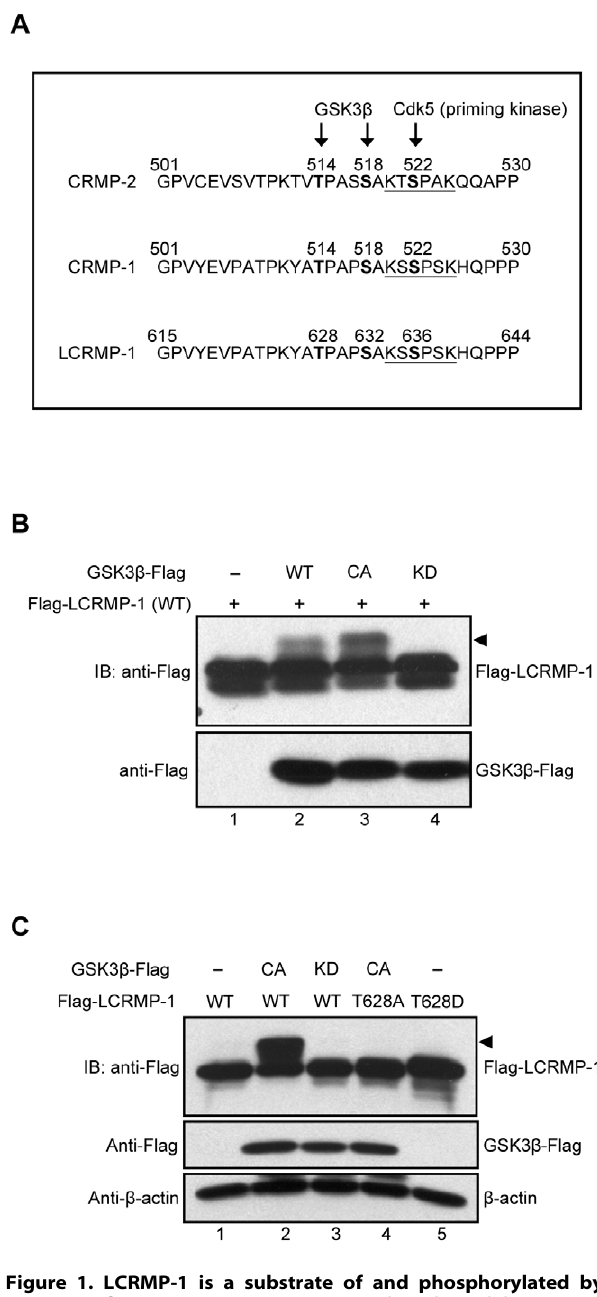
Figure 1. LCRMP-1 is a substrate of and phosphorylated by GSK3 b at Thr-628. (A) Protein sequence analysis showed the potential consensus site of LCRMP-1 for the phosphorylation by GSK3 b . Protein sequences are aligned among CRMP2, CRMP-1, and LCRMP-1. The numbers represent amino acid sites and underline shows a potential phosphorylation site for Cdk5. (B) GSK3 b phosphorylates LCRMP-1 (WT) in vivo . HEK293T cells were co-transfected with Flag-tagged LCRMP-1 and distinct activity of Flag-tagged GSK3 b (WT, CA and KD form). Equal amount of plasmids were transfected into every condition by using empty vectors. Cells were lysed 30 hr post-transfection and protein extracts were analyzed by immunoblotting with anti-Flag antibodies. (C) GSK3 b phosphorylates LCRMP-1 (WT) at Thr-628 in vivo . CL1-0 cells were co-transfected either Flag-tagged LCRMP-1(WT) or LCRMP-1 (T628A, T628D) mutants in the presence or absence of distinct activity of Flag- tagged GSK3 b (CA and KD form). Empty vectors were used for supplement to equal amount of plasmids in transfection assay. Cell lysates were harvested 48 hr post-transfection and analyzed by immunoblotting with anti-Flag and anti- b -actin antibodies.